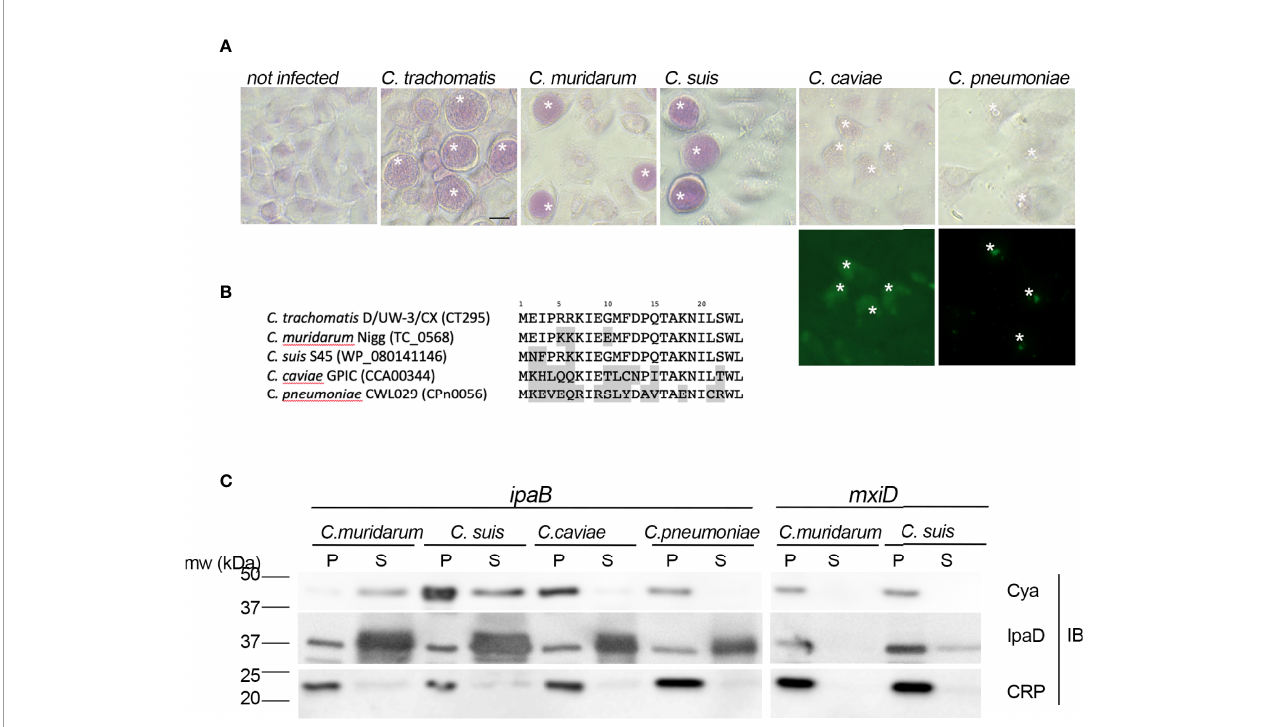
FIGURE 5 | The presence of a functional T3S signal in the PGMs of Chlamydiaceae correlates with glycogen storage in inclusions. (A) – Top panels: PAS staining of cells infected with the indicated strains. Bottom panels: C. caviae and C. pneumoniae infected cells were further stained with anti-mGroEL antibody followed with Alexa488-conjugated secondary antibodies to detect the inclusions (asterisks). Bar is 20 m m. (B) – Alignment of the fi rst 24 amino acids of CT295 and its orthologs in the indicated Chlamydiaceae species. Amino acids that differ from the C. trachomatis sequence are shadowed. (C) – The fi rst 22 amino acids of the indicated CT295 orthologs were fused to the Cya reporter protein and expressed in a S . fl exneri ipaB (left) or mxiD (right) strains. Secretion was analyzed like in Figure 4A